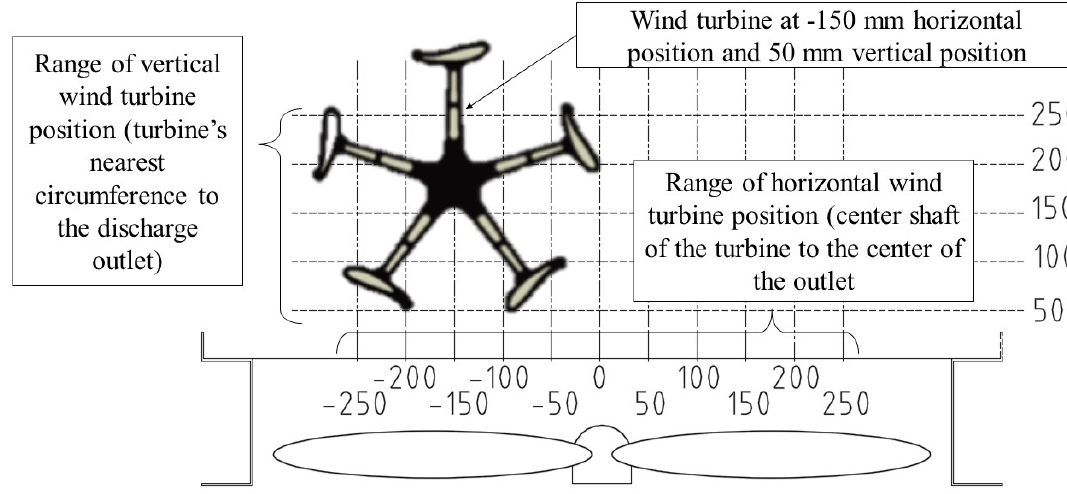
Figure 5. Horizontal and vertical range for turbine positioning